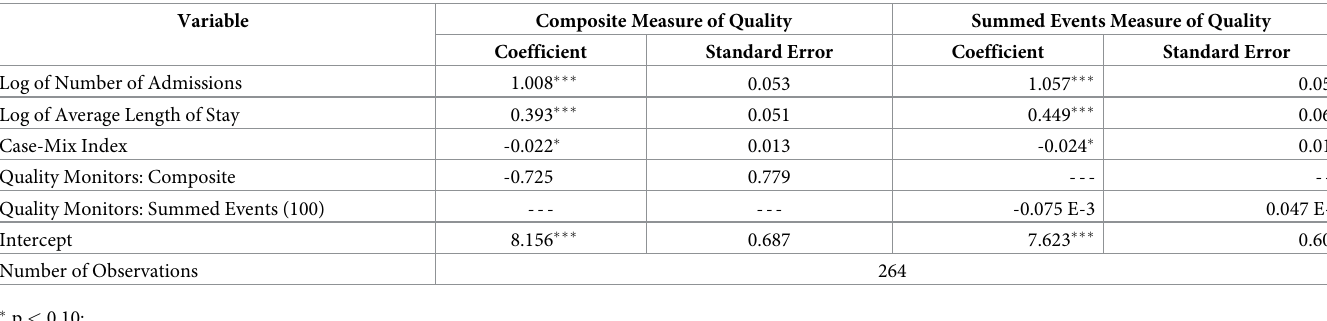
Table 4. Generalized linear model estimates of nursing variable costs.